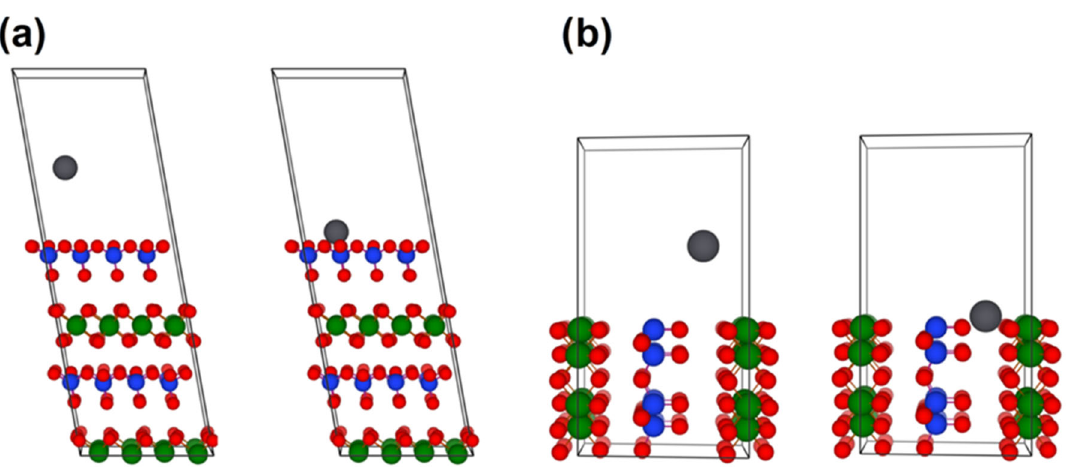
Figure 5. The slab supercell of halloysite (7 Å) structure that was used to simulate the adsorption energy of Pb, Hg, and Cd on: ( a ) external siloxane surface, ( b ) cross ‐ sectional interlayer surface. Green, blue, and red spheres represent aluminum, silicon, and oxygen atoms, respectively. The adsorption energy can be expressed as the difference between the total energy of a relaxed system with an adsorbed metal ion on the surface and the total energy of a separated system (compared in Table 8):